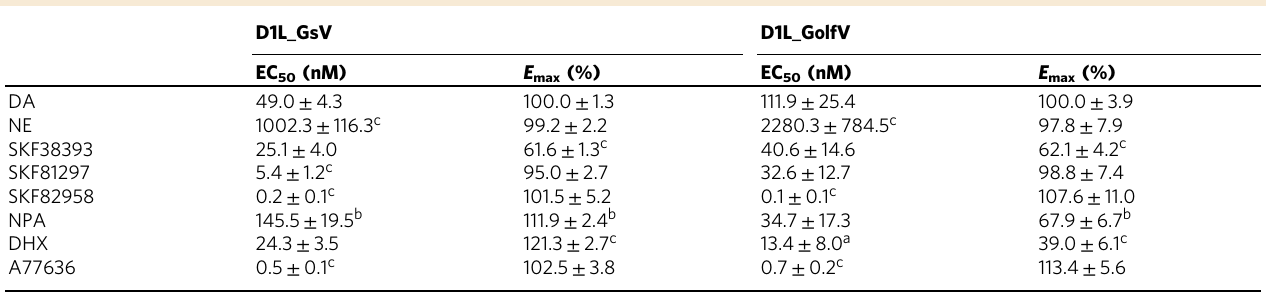
Table 1 Pharmacological comparison of Gs and Golf engagement in